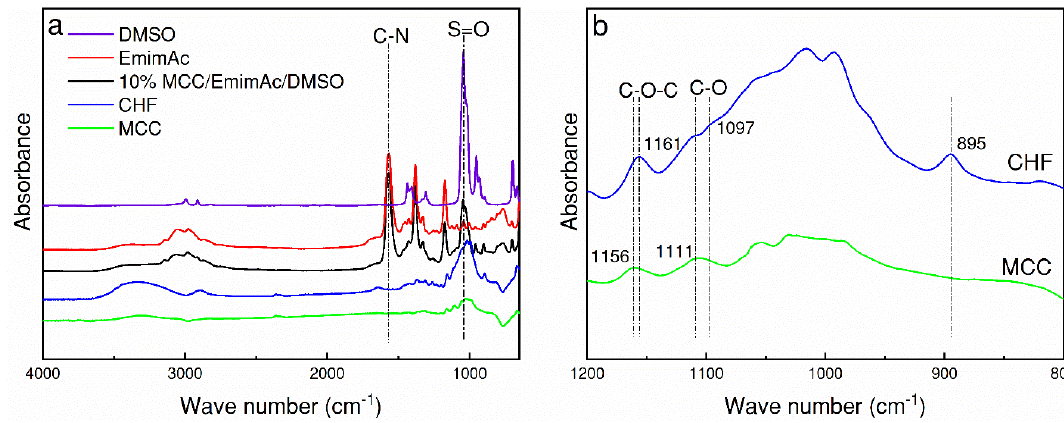
Figure 6. FTIR spectra of ( a ) solvents, polymer solution, MCC and CHF; ( b ) zoom in the range of 800-1200 cm -1 for MCC and CHF.